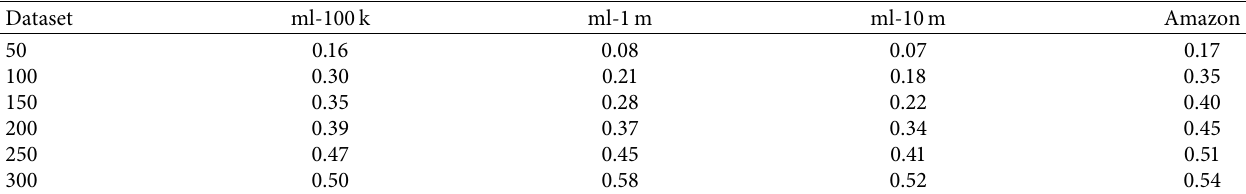
Table 3: Recall on different